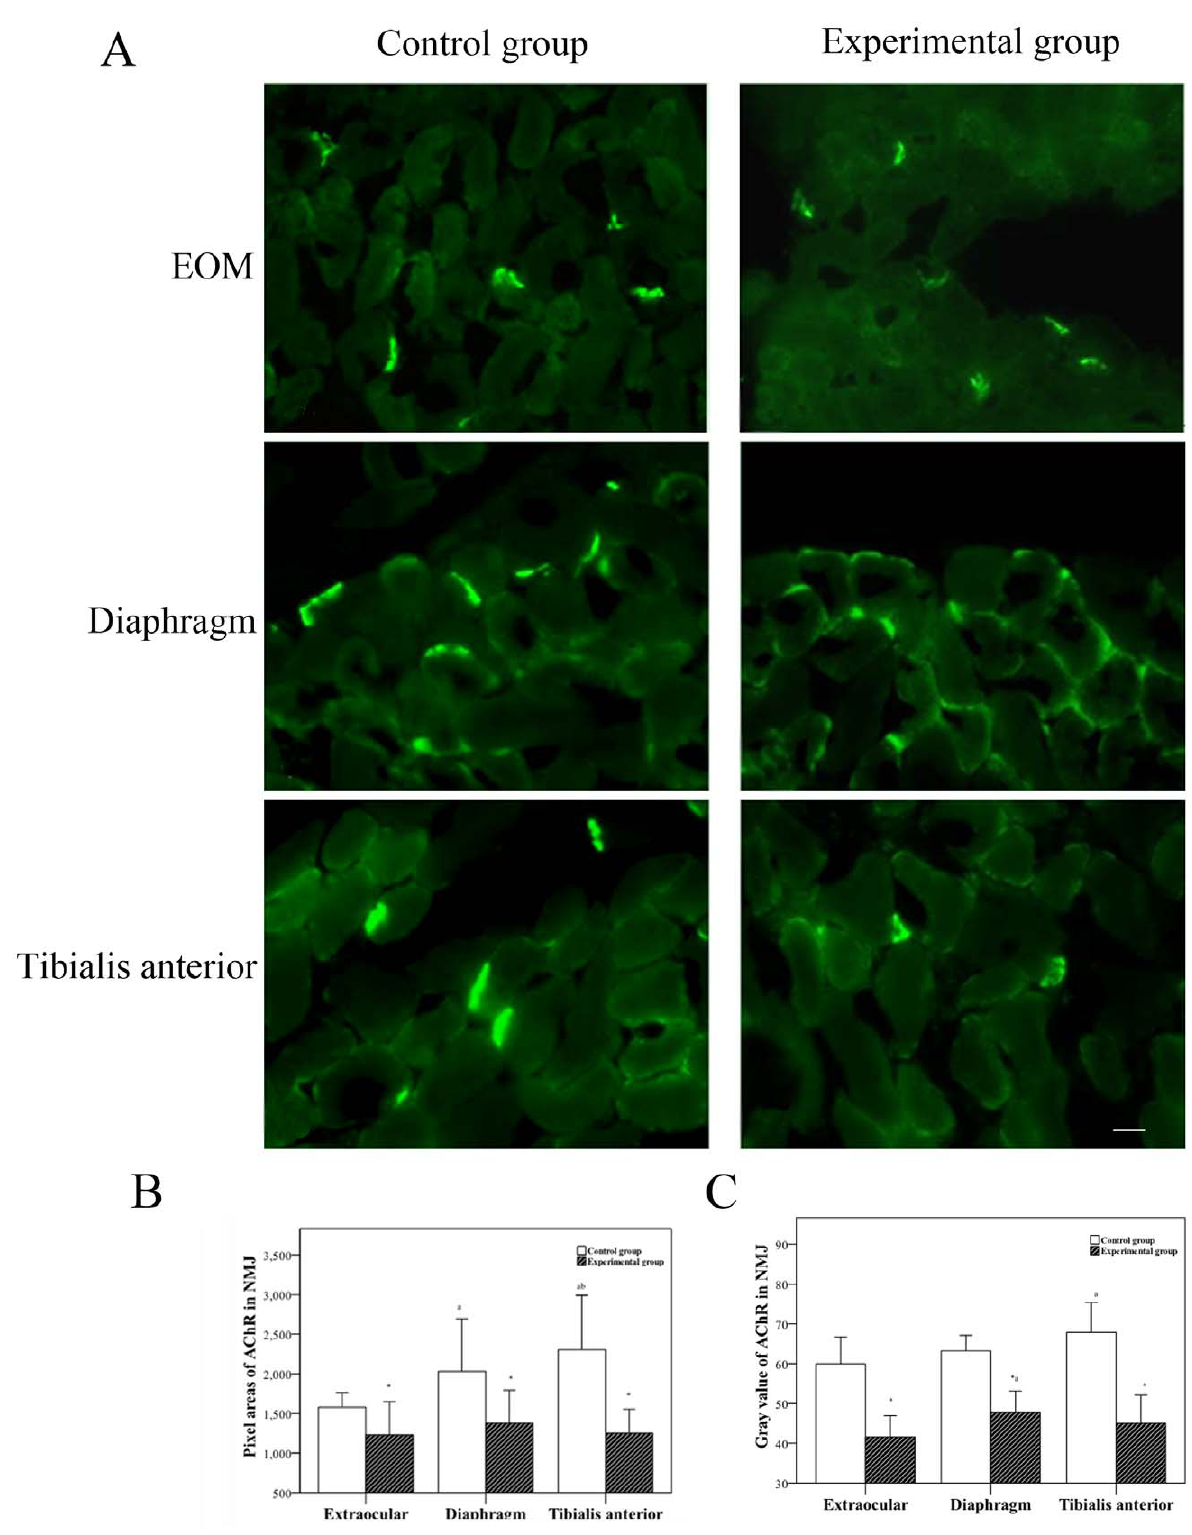
Figure 4. Comparision of AChRs in the NMJ of different muscles by fluorescence histochemistry. A. Acetylcholine receptors (AChRs) labeled with a -bungarotoxin in the neuromuscular junction (NMJ) of three muscles in the two groups. B. Determination of pixel areas in NMJ by an automatic analyzer. C. Determination of gray value in NMJ by an automatic analyzer. *Significant ( P , 0.05) difference between the control and experimental groups determined by independent two-sample t test. a Statistically significant difference between indicated group and EOM group. b Statistically significant difference between indicated group and diaphragm group. Scale bar=10 m m.